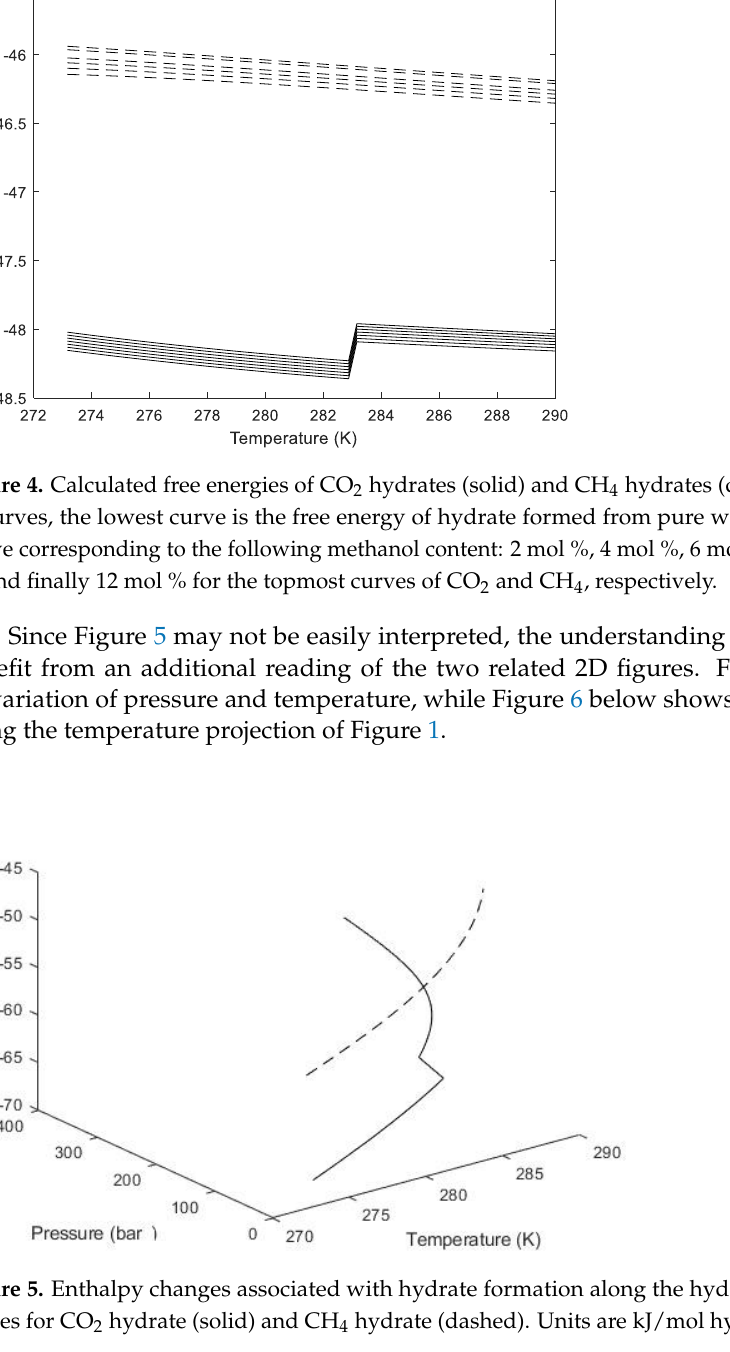
Figure 5. Enthalpy changes associated with hydrate formation along the hydrate P-T equilibrium curves for CO 2 hydrate (solid) and CH 4 hydrate (dashed). Units are kJ/mol hydrate former.